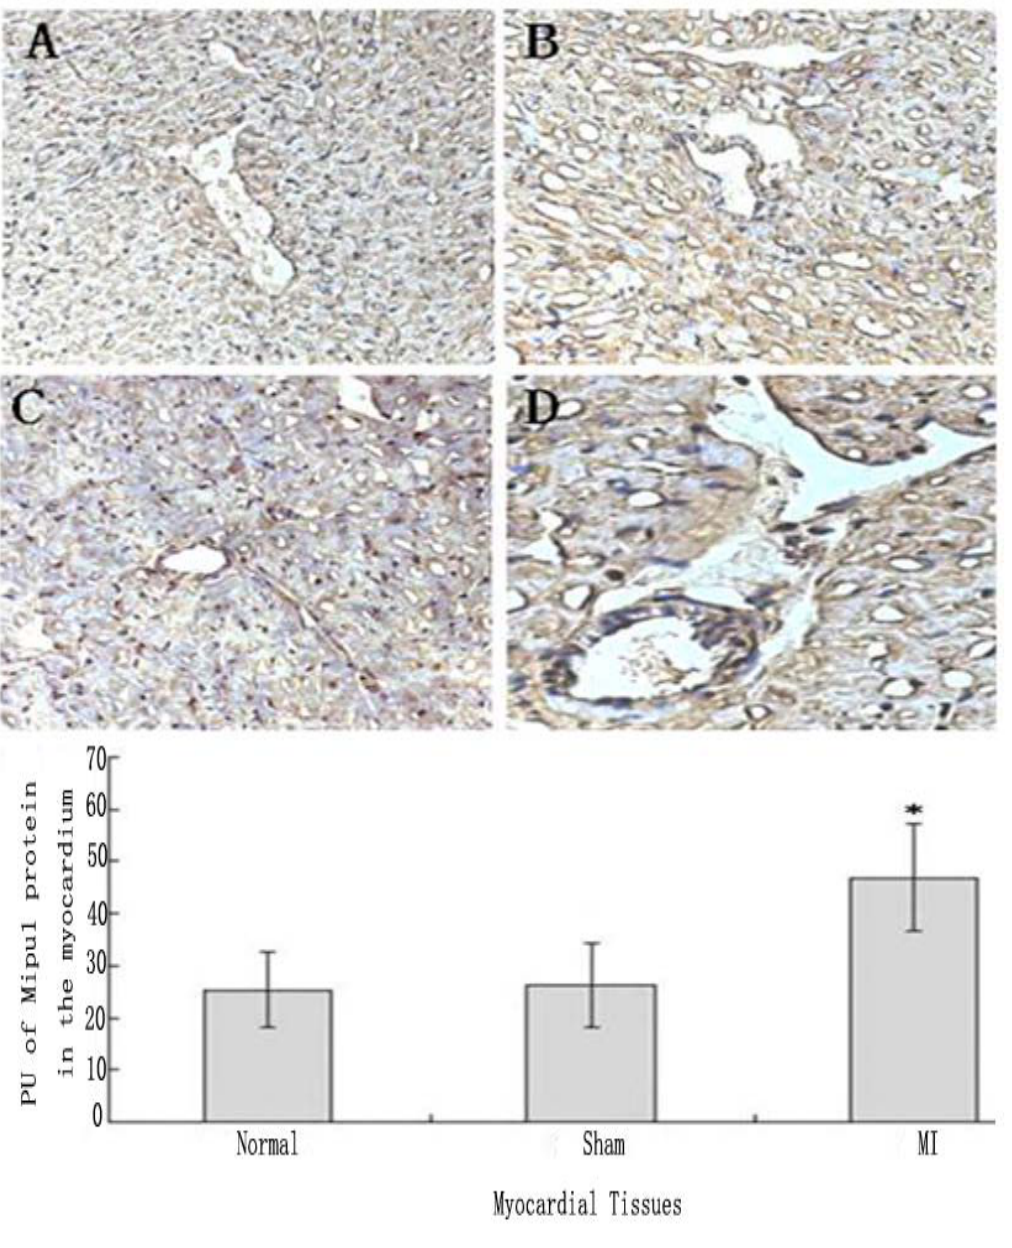
Figure 5. Immunohistochemical staining analysis of Mipu1 protein in cardiomyocytes and endothelial cells of sham-operated and infarct hearts. A: Cardiomyocytes and endothelial cells in normal heart; B: Cardiomyocytes and endothelial cells in sham heart; C: Infracted myocardium. D: Blood vessels in the infracted myocardium. (200×). * vs Normal, P < 0.05,